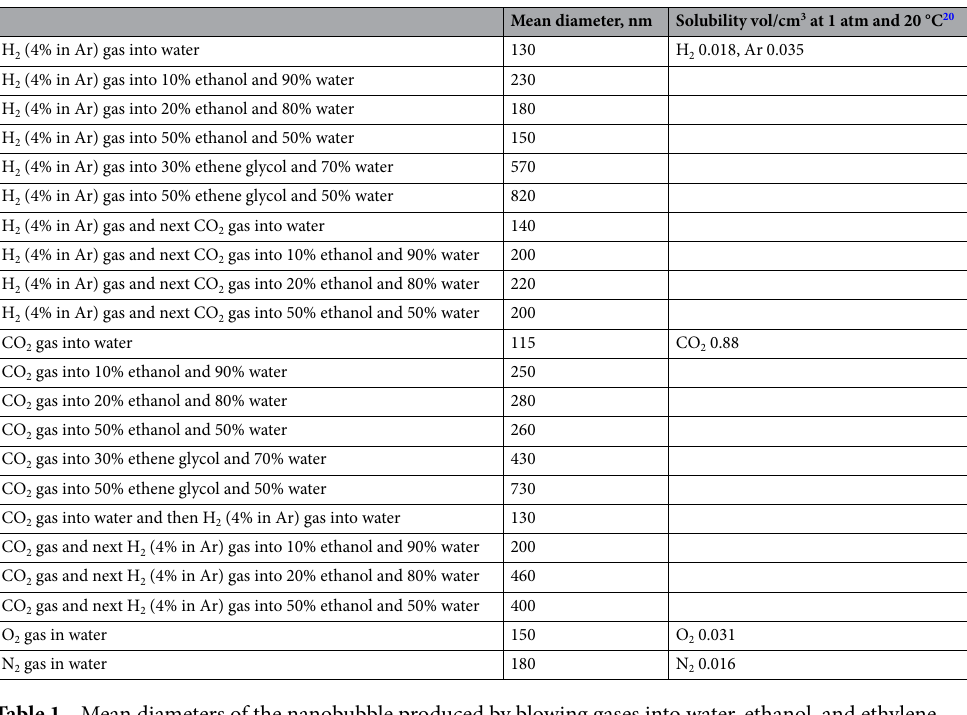
Table 1. Mean diameters of the nanobubble produced by blowing gases into water, ethanol, and ethylene glycol solution through porous ceramics for every 30 min.